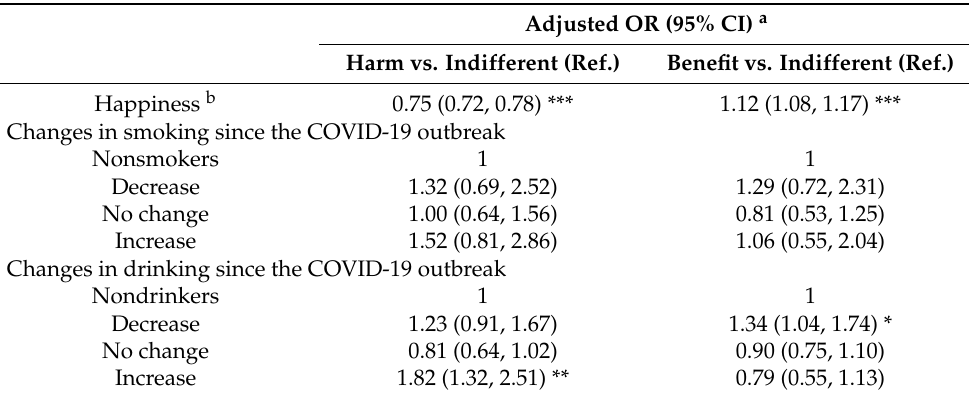
Table 6. Associations of happiness and changes in smoking and drinking with identified subgroups of perceived harms and benefits (N = 4520). Adjusted OR (95% CI) a Harm vs. Indifferent (Ref.) Benefit vs. Indifferent